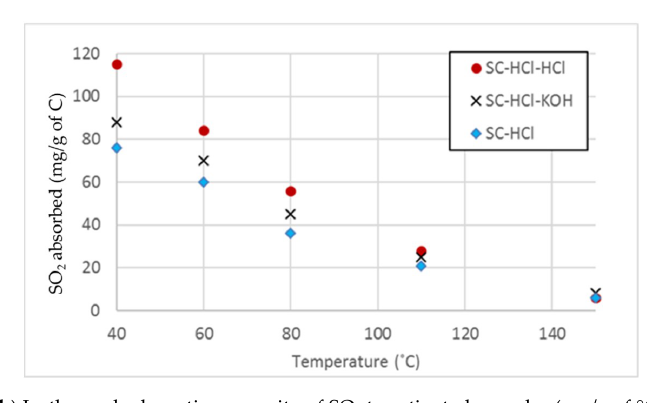
2 to activated semi-coke